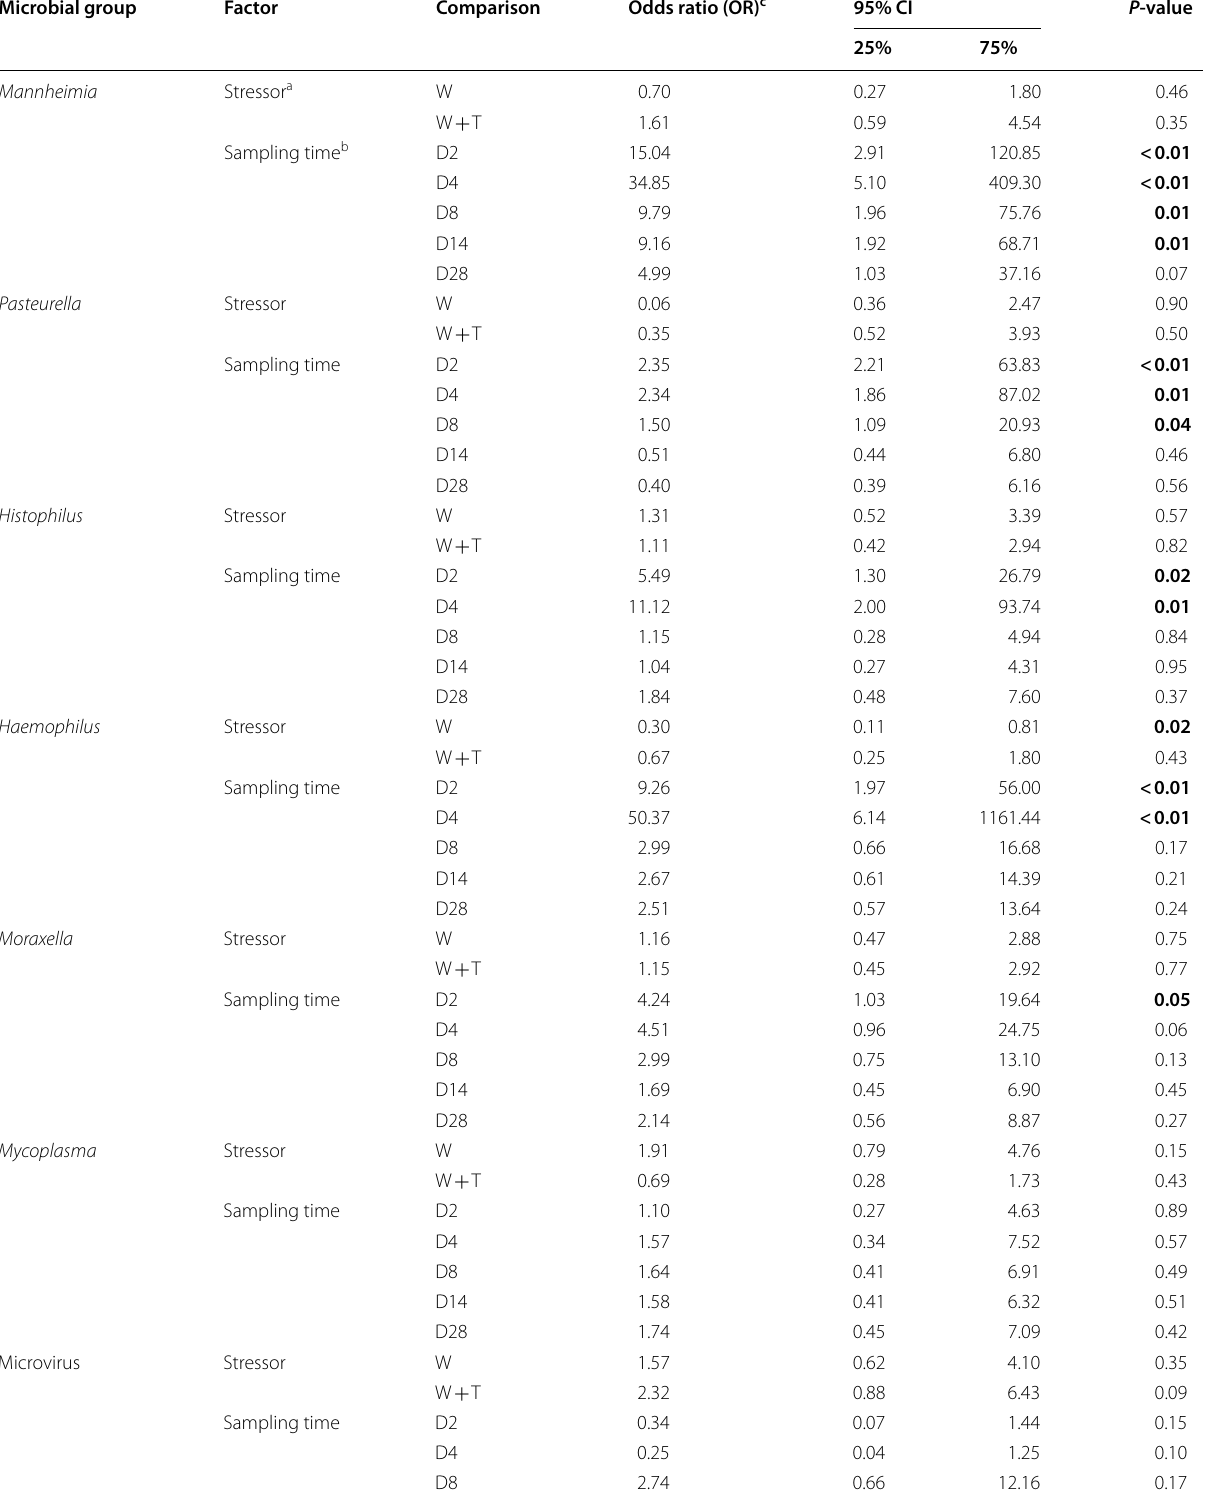
Table 2 Relationship between colonization by opportunistic pathogens and bacteriophage in the URT of beef calves with weaning and transportation stressors and sampling time points Microbial